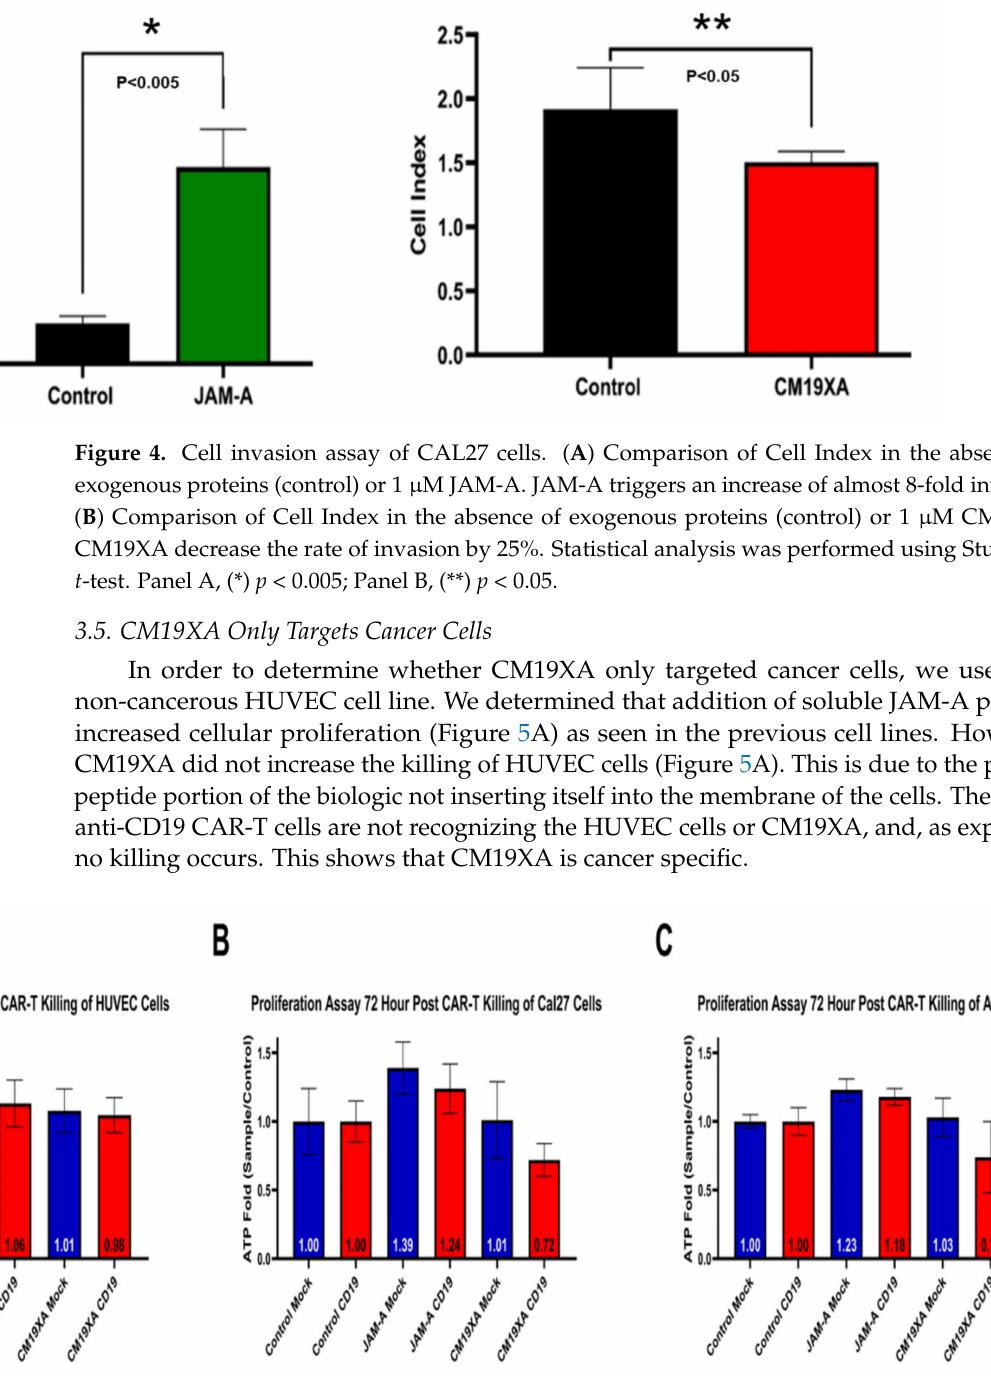
Figure 5. Proliferation Assay after 72-h post CAR-T cytotoxic assay of HUVEC, CAL27, or A549 cancer cells. ( A ) As expected, CM19XA did not increase killing of HUVEC cells. This is because the pHLIP portion of the protein did not insert itself into the membrane of the noncancerous HUVEC cells. ( B ) Control resulted in the same results where there was no change in the proliferation, as expected. JAM-A resulted in an increase of proliferation in both mock and anti-CD19 CAR-T, validating the results from the wound healing assay and the other proliferation assays. CM19XA mock had